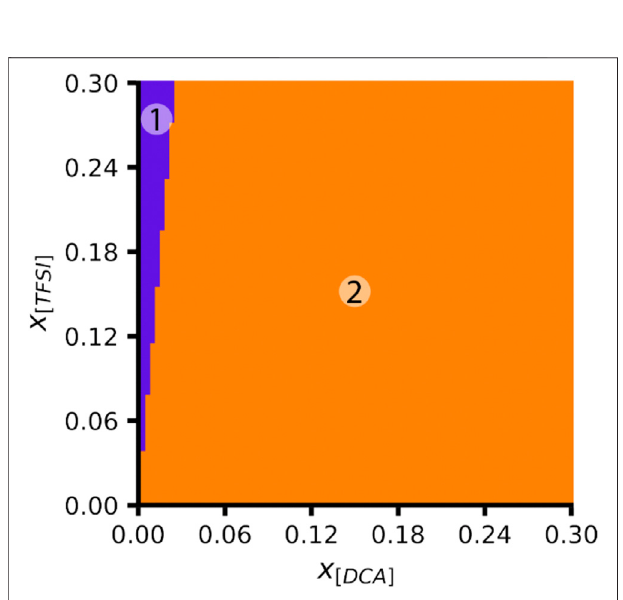
FIGURE 9 | Phase diagram for Li + solvates calculated in the ab initio thermodynamic analysis as a function of the mole fractions of [DCA] and [TFSI]. Color key: the purple region (1) (cid:1) (Li[TFSI] 2 ) − 1 and the orange region (2) (cid:1) (Li[DCA] 2 ) − 1